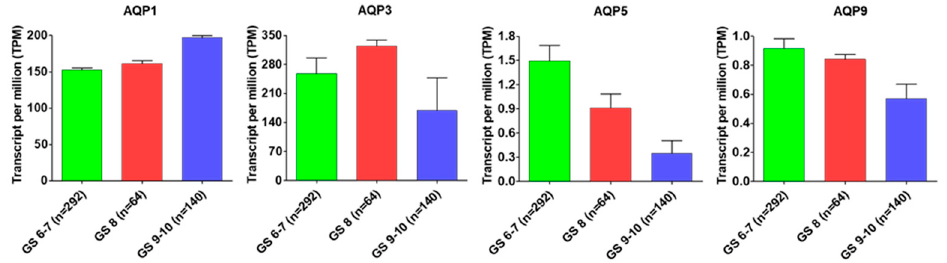
Figure 2. AQPs expression status with Gleason score. AQP1, AQP3, AQP5 and AQP9 expression status with Gleason score in prostate adenocarcinoma (PRAD) based on the cancer genome atlas (TCGA) dataset.